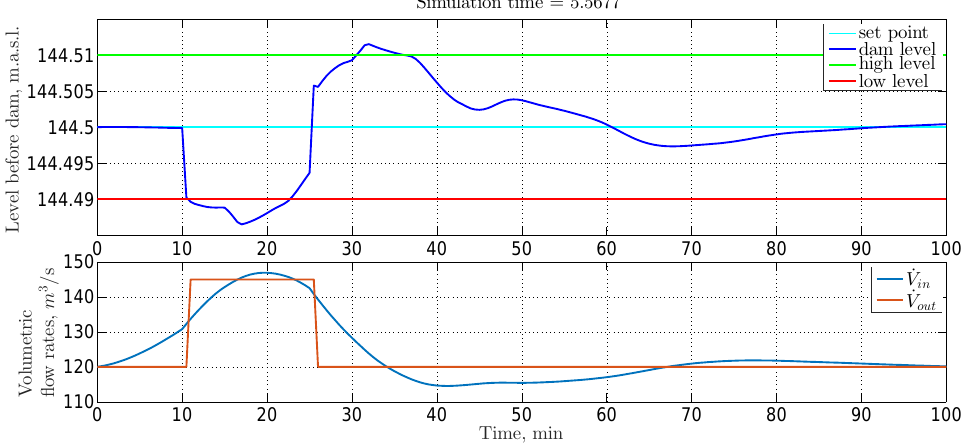
Figure 11: The results of simulation of P controller with Smith predictor ( T s = 30 and K p = 70).